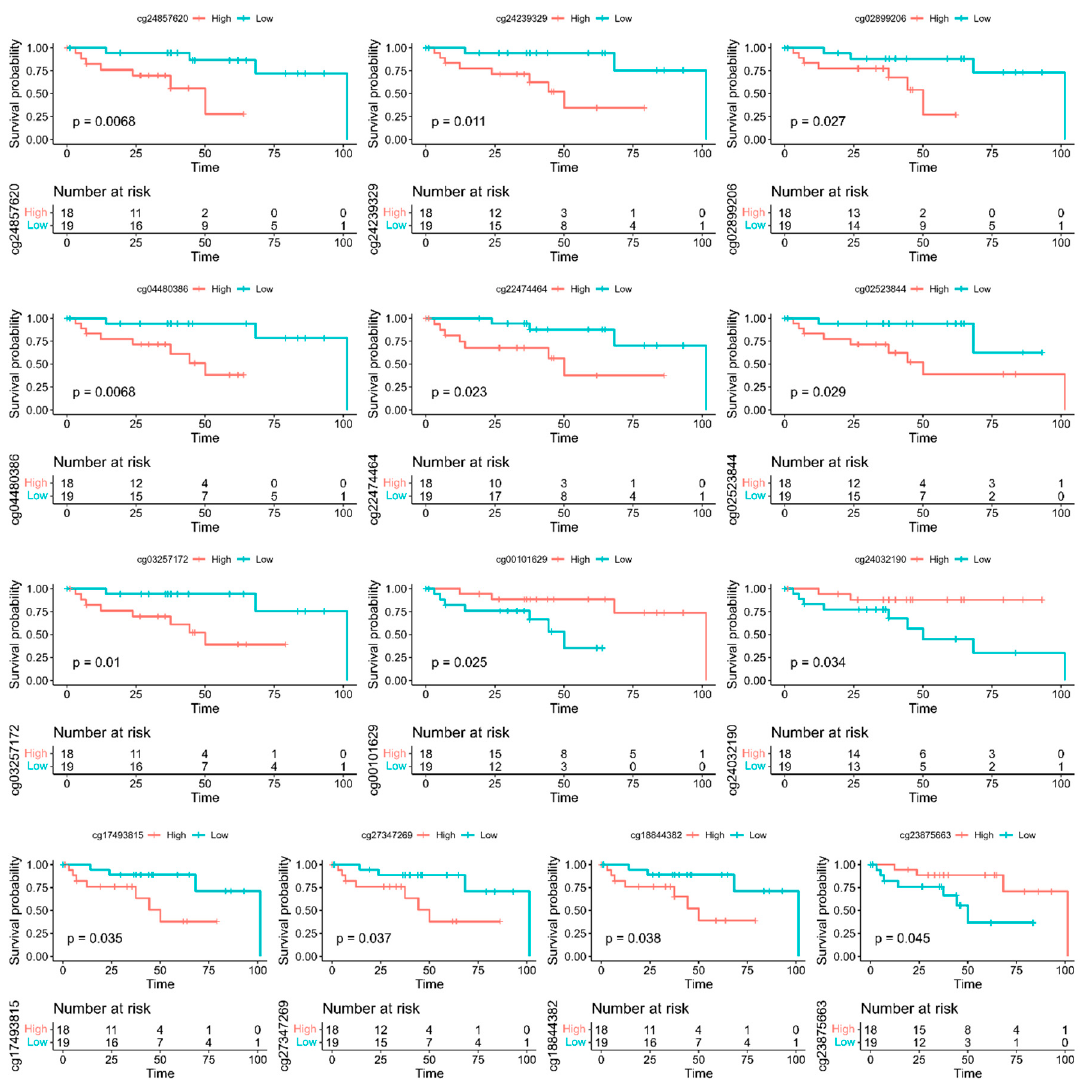
Figure 4. Kaplan–Meier survival analysis of clusters of samples defined by 13 CpG sites , time